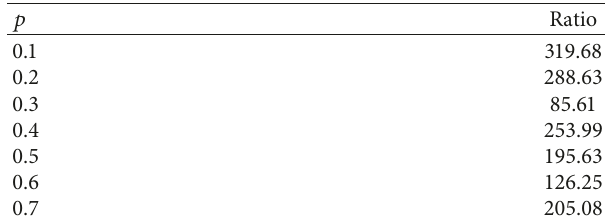
Table 3: Ratio of different fault